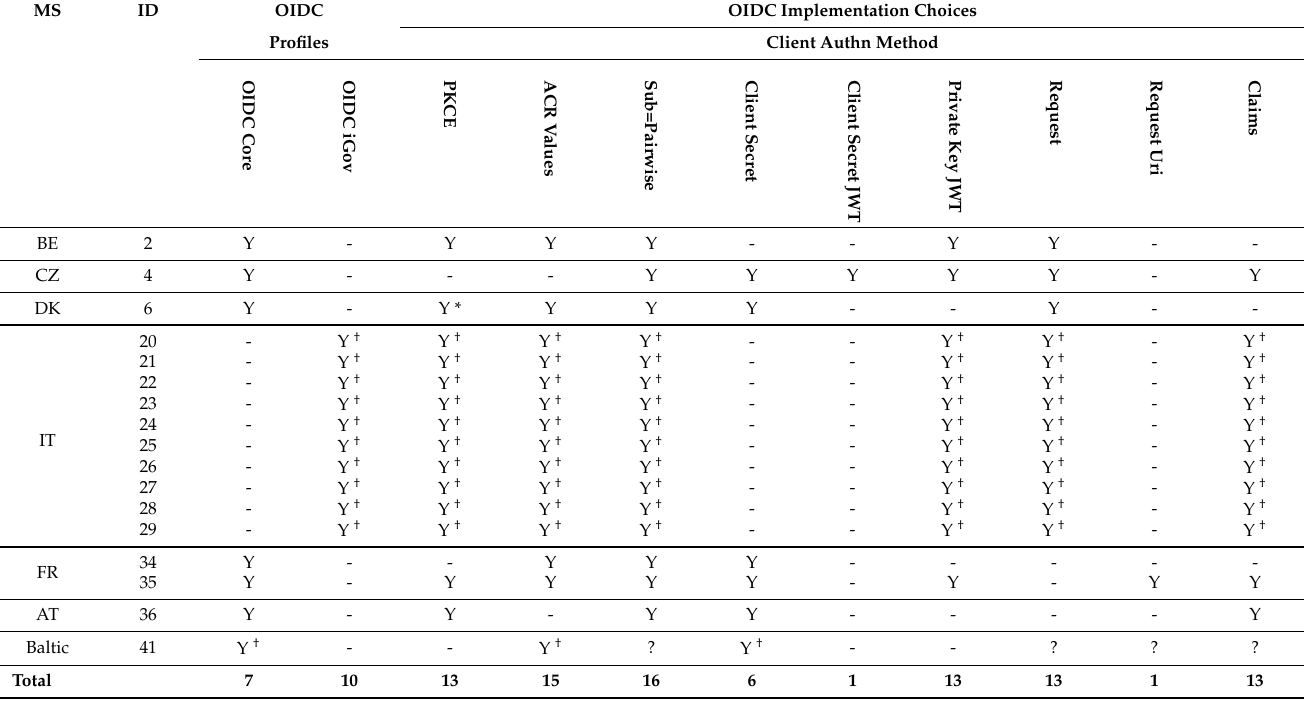
Table 3. Analysis results of OIDC-based eID schemes for RQ3 and